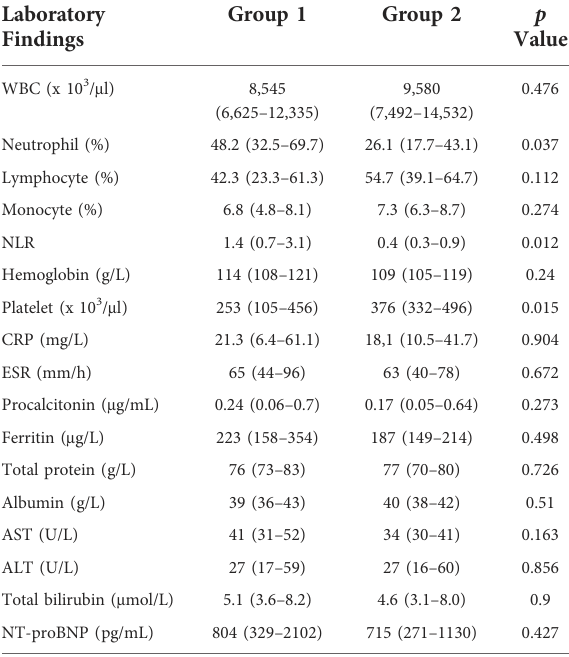
TABLE 5 Comparison of medications used during acute treatment between the two